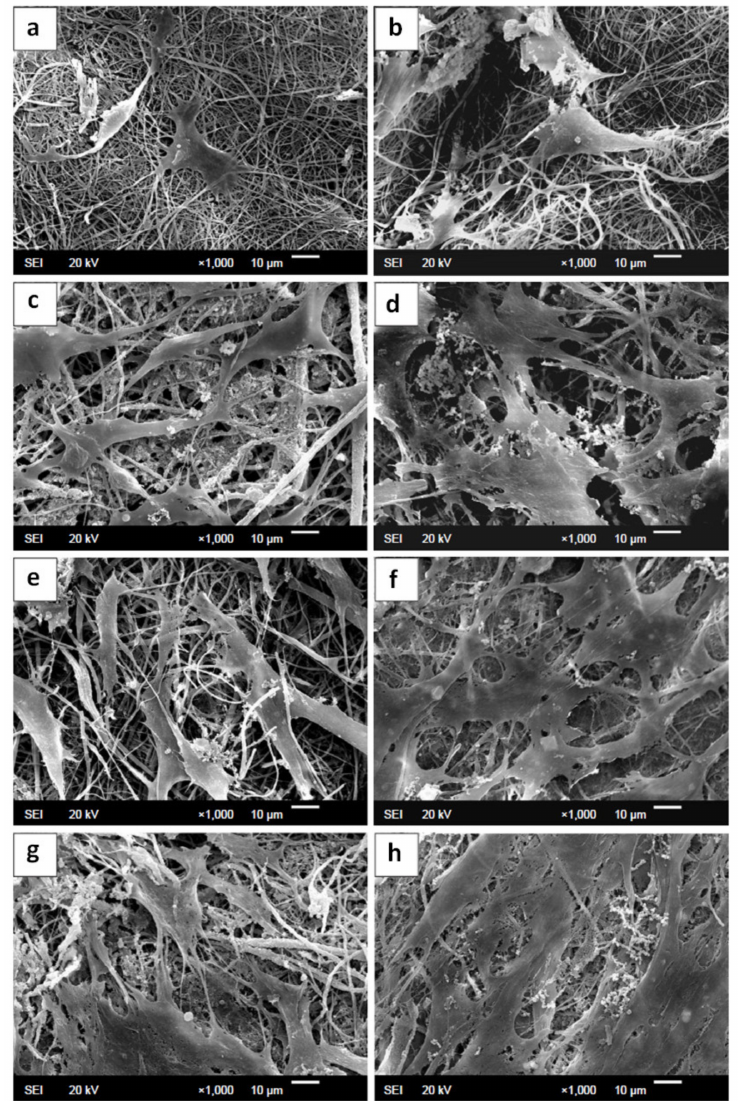
Figure 8. Scanning electron microscope (SEM) images of BMSCs on the surface of ( a , b ) CS, ( c , d ) A0, and ( e , f ) A1 and ( g , h ) A2 after ( a , c , e , g ) 4 days and ( b , d , f , h ) 7 days of incubation. Abbreviations: BMSCs, bone marrow stromal cells; CS, chitosan; SEM, scanning electron micrograph. Reproduced from [81], with permission of Jin et al. 2018. Abbreviations: CS, chitosan; A0, Ratio of CS to calcium phosphate is 4:1 and silver content is 0; A1, Ratio of CS to calcium phosphate is 4:1 and silver content is 0.075%; A2, Ratio of CS to calcium phosphate is 4:1 and silver content is